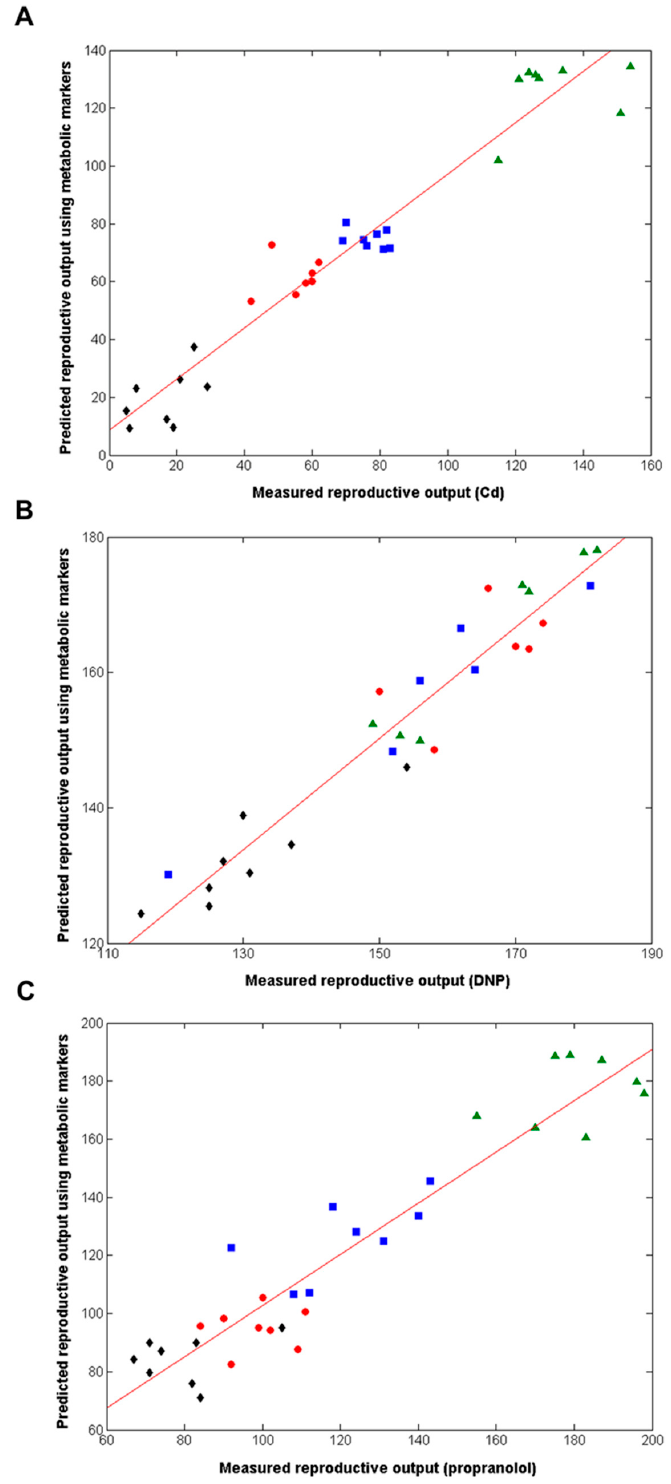
Figure 3. Correlation between measured and predicted reproductive output for individual D. magna , the latter derived from forward-selected PLS-R models built using the metabolomics datasets, following chronic exposure to ( A ) Cd, ( B ) DNP and ( C ) propranolol, including lines of best fit. The cross-validated R 2 values are 0.935 for Cd (561 peaks, 2 LVs), 0.945 for DNP (306 peaks, 3LVs) and 0.893 for propranolol (606 peaks, 3LVs); p = < 0.001 in all cases. Classes comprise of control ( ), Low dose ( ), medium dose ( ) and high dose(s) ( ).